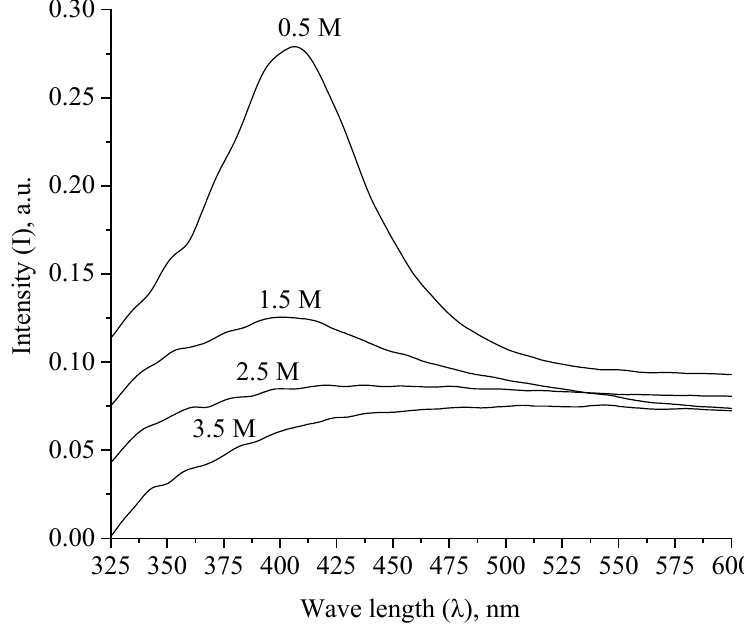
Figure 11. Absorption spectra of Ag NPs with different values of ionic strengths of solutions.